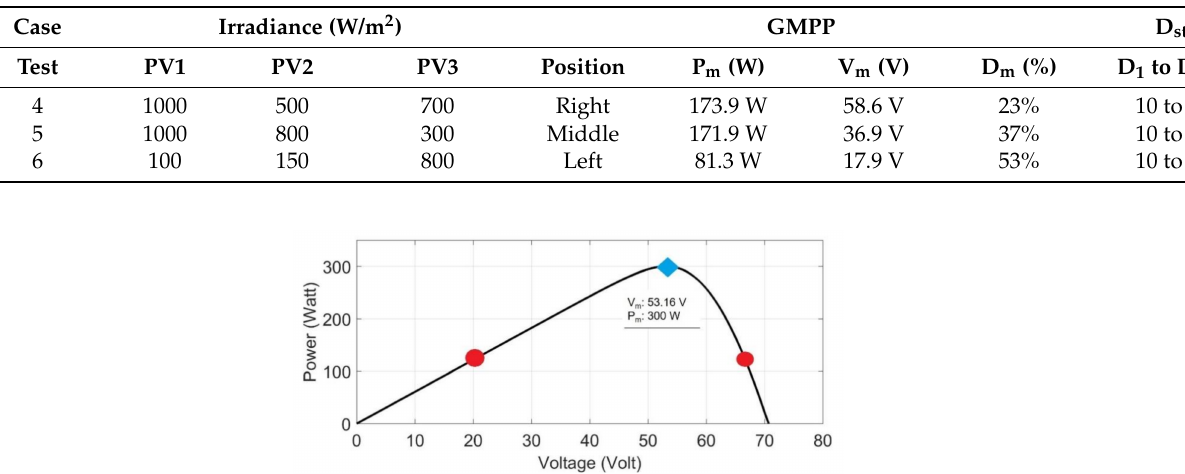
Table 4. Partial Shading Tests.